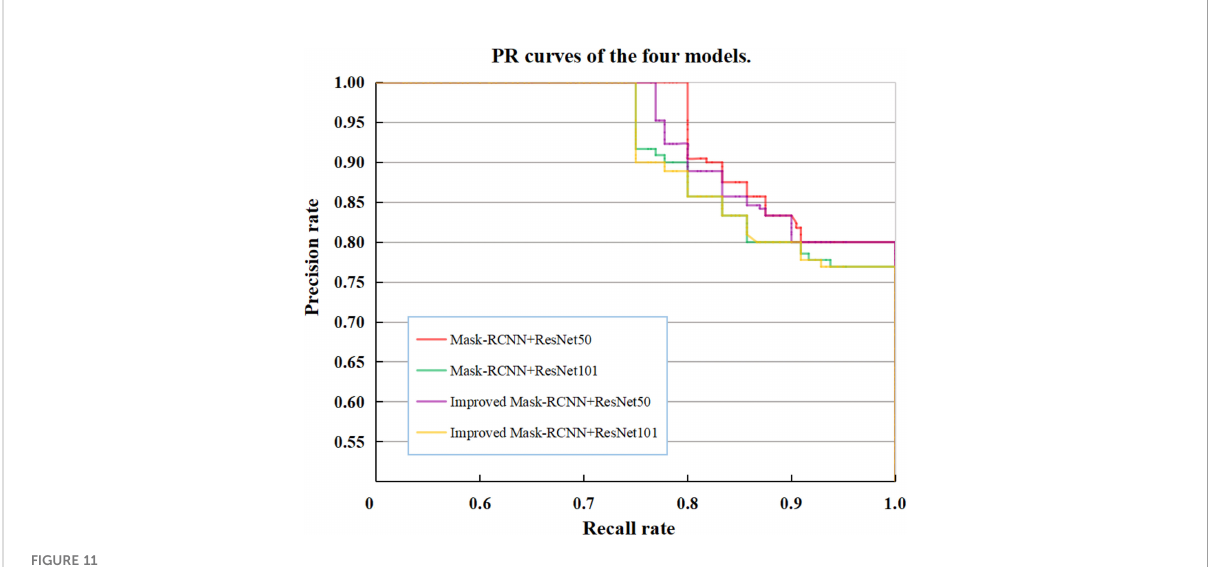
FIGURE 11 PR curves of the four models.